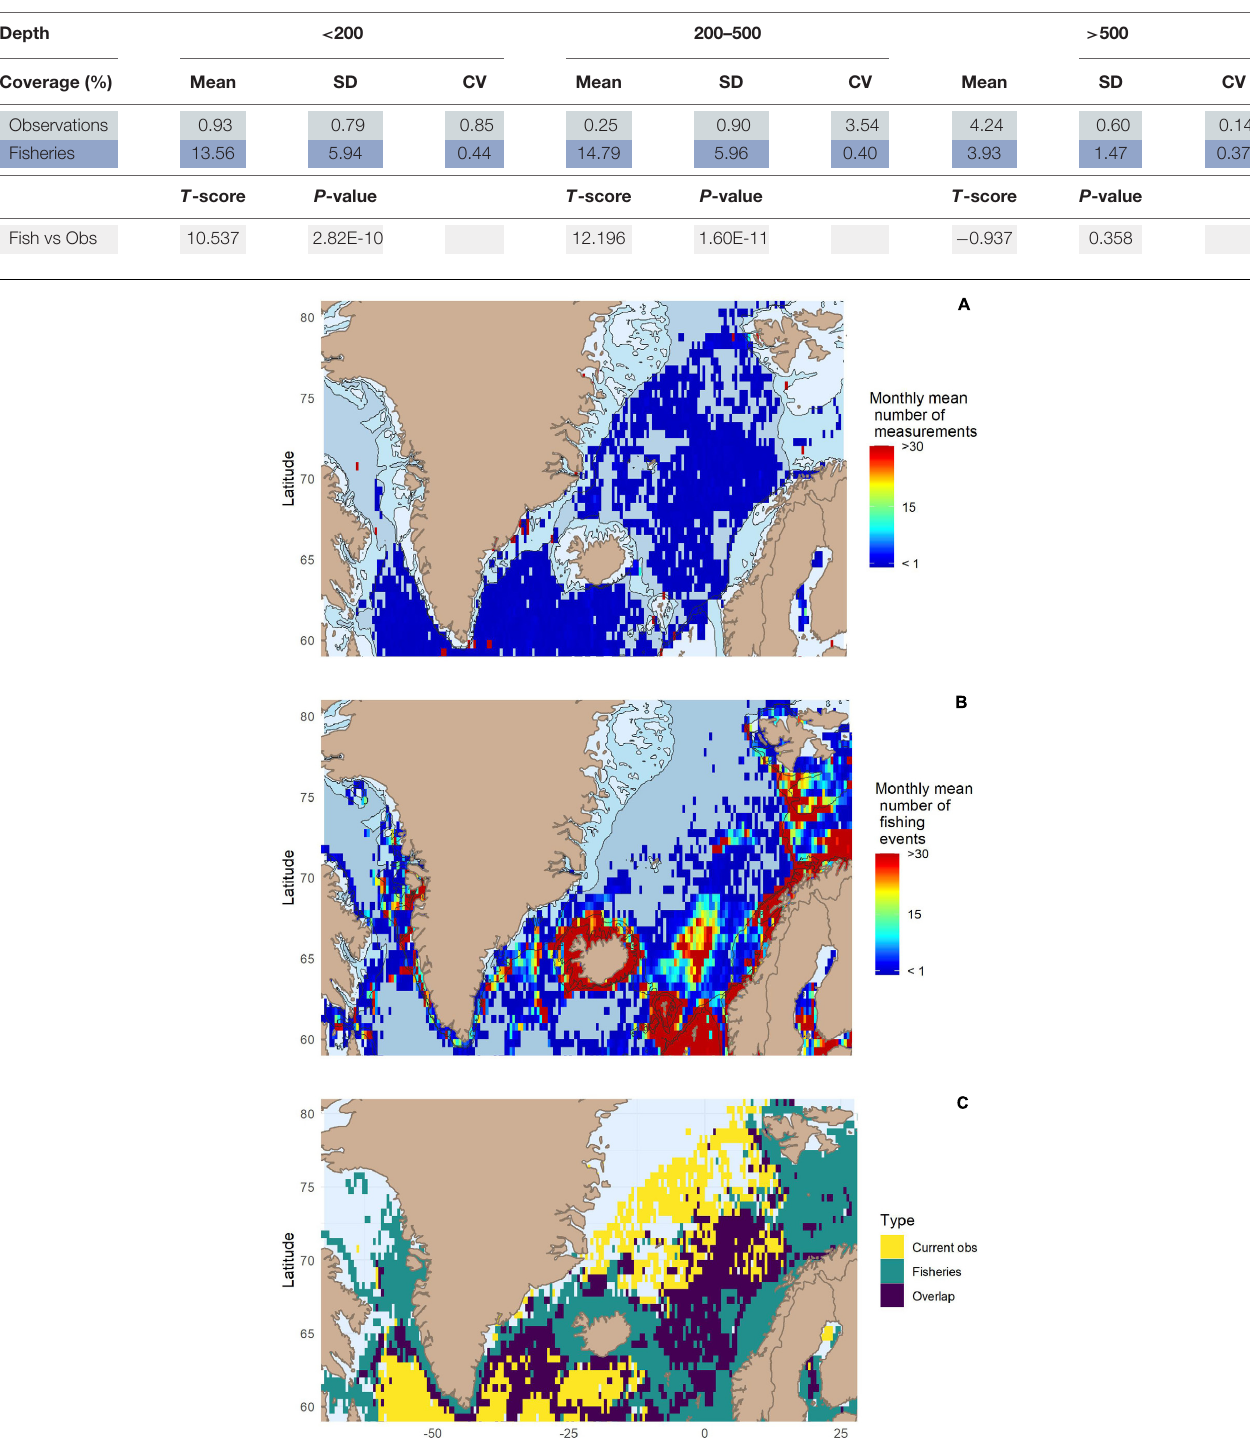
TABLE 2 | Summary statistics comparing observation and fisheries coverage in the Alaska focus region. SD corresponds to ( Figure 6 ) error bars. Depth < 200